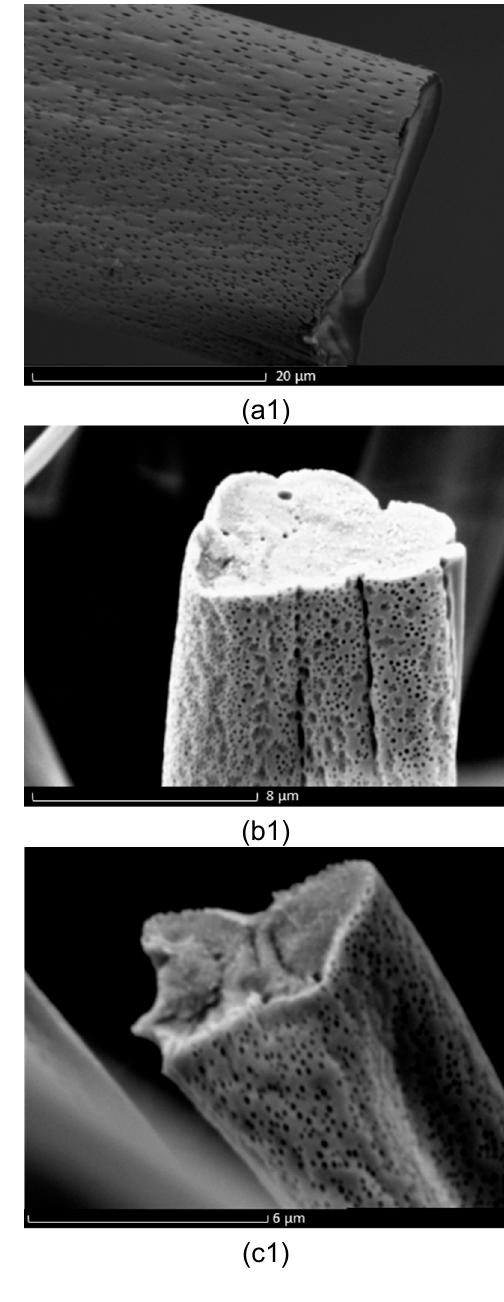
Figure 5. Scanning electron microscope images of cross sections of PMMA fibers: chloroform ( a , a1 ); dichloromethane (DCM) ( b , b1 ); ethyl acetate ( c , c1 ).